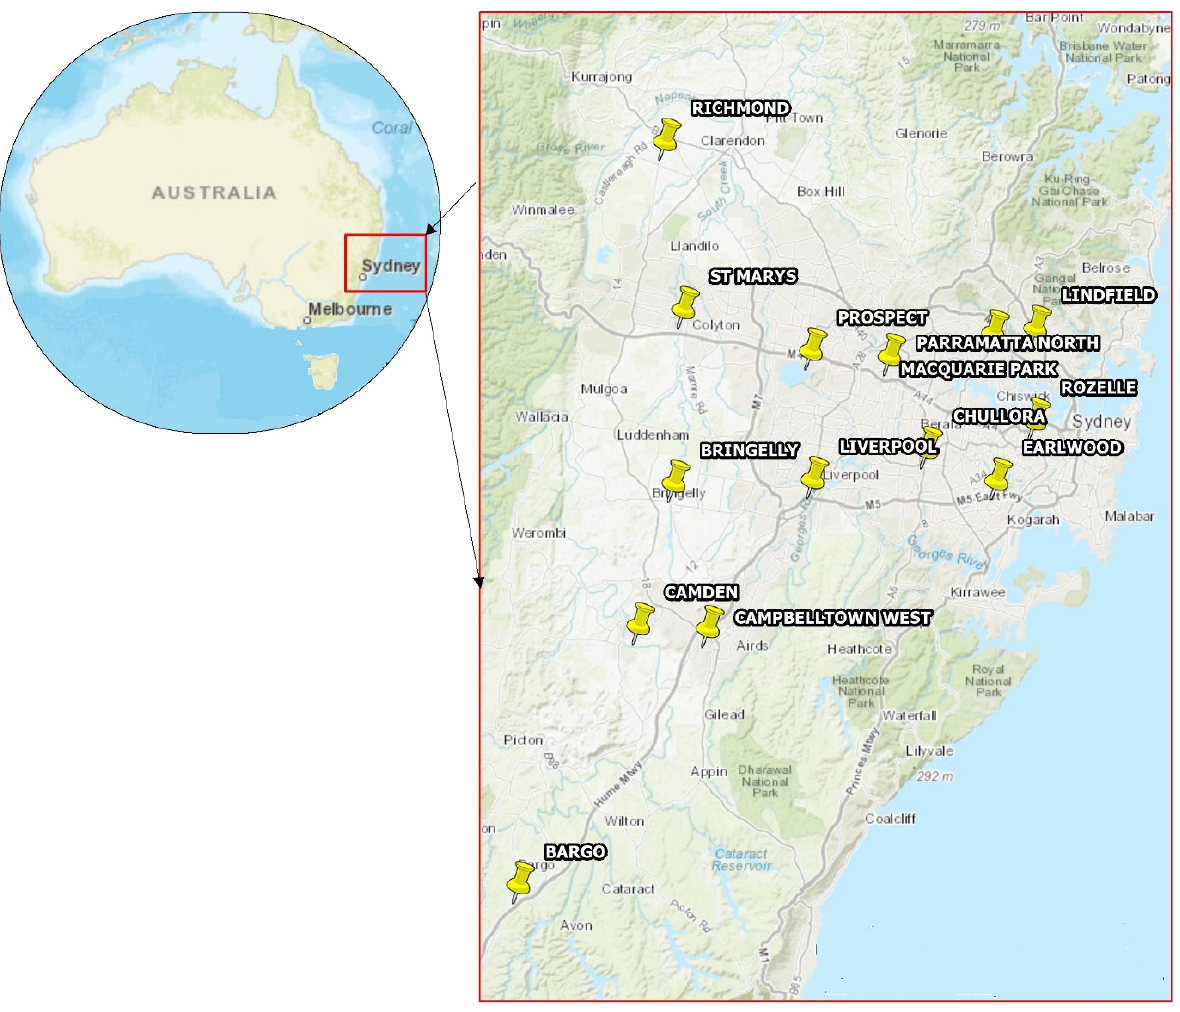
Figure 2. The locations of air quality monitoring stations in the Sydney area (yellow pins) were plotted on a map using an ArcGIS program to explain their spatial distributions.